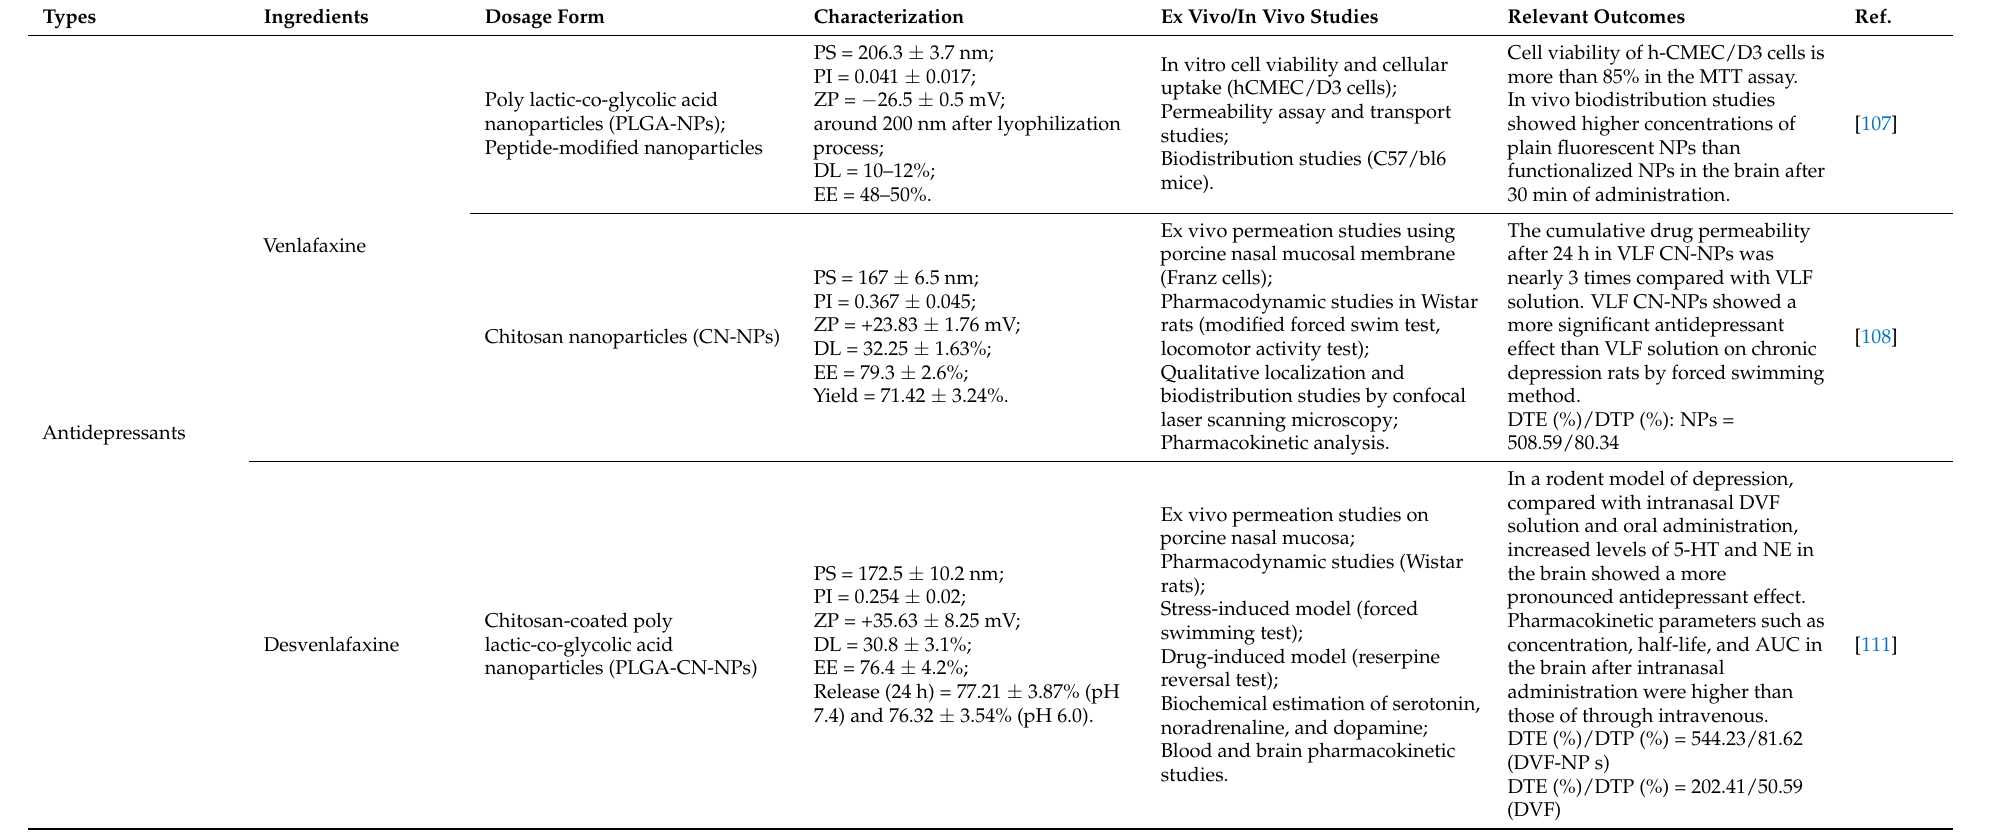
Table 1. Summary of studies on antidepressant active ingredients and new dosage forms for intranasal